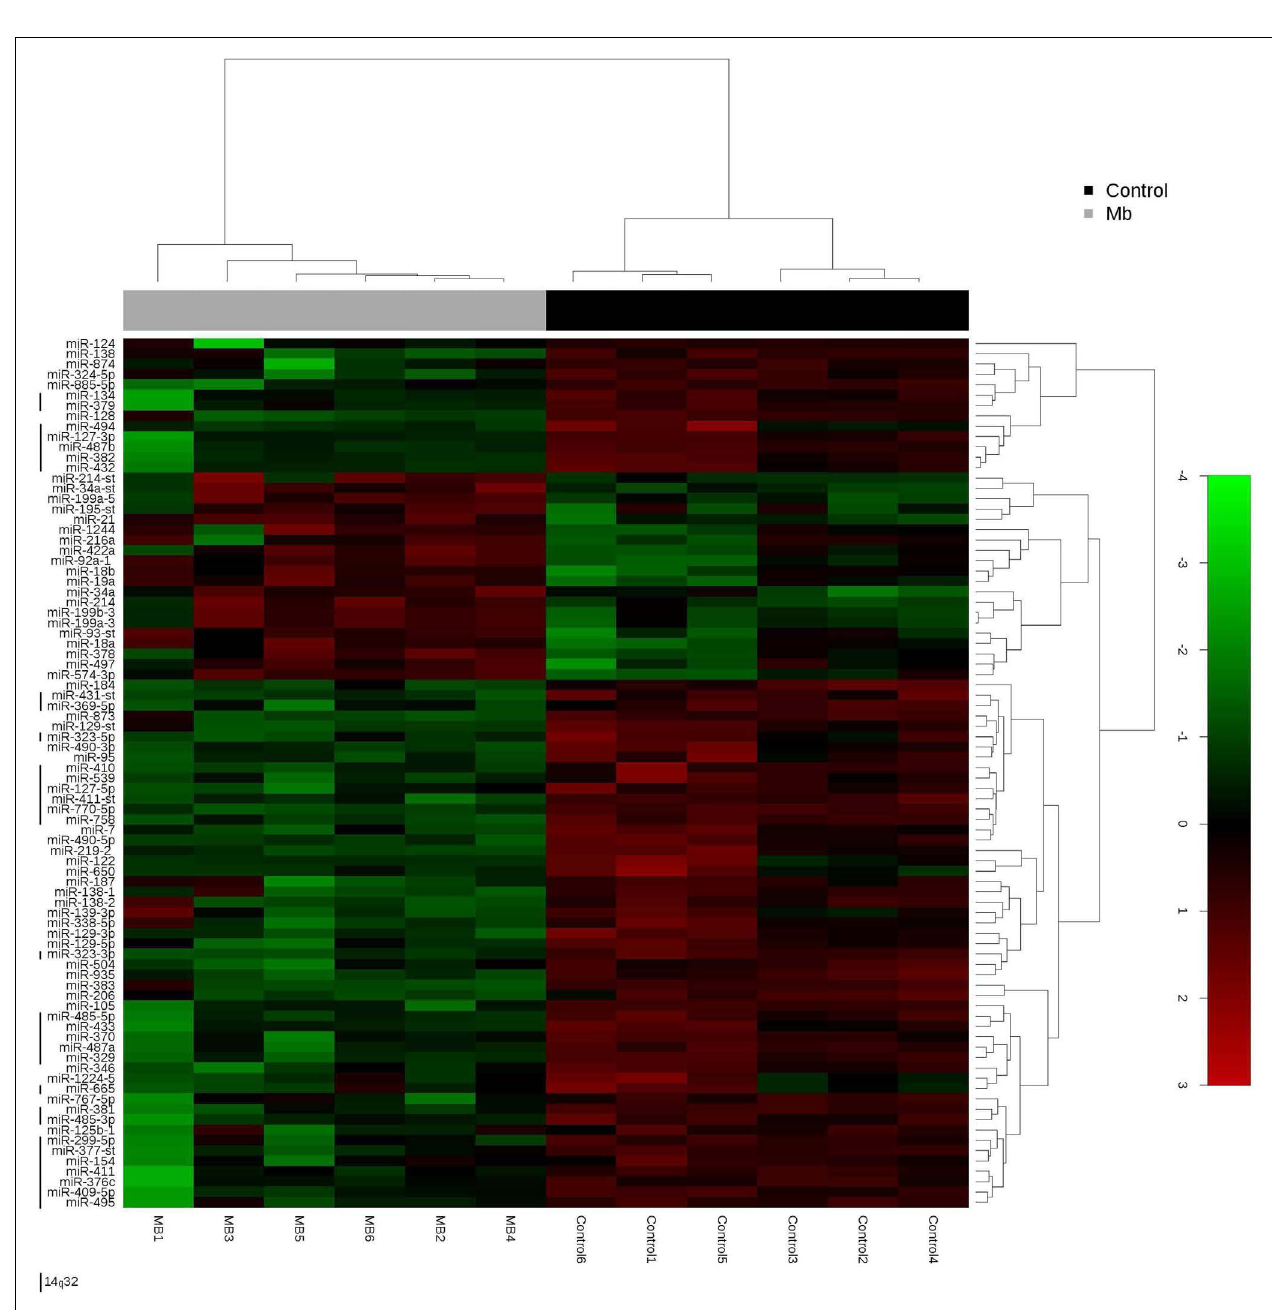
FIGURE 1 | Hierarchical clustering analysis of medulloblastoma and normal cerebellum . Unsupervised hierarchical cluster analysis representing the 84 miRNAs expressed in medulloblastoma samples versus normal cerebellum. 14q32 miRNAs are depicted by a left vertical line. -st, star.